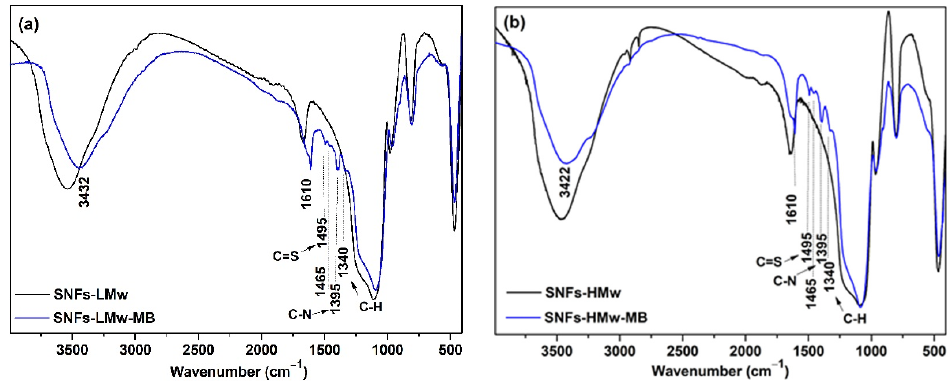
Figure 8. FTIR spectra before and after MB adsorption for ( a ) SNFs-LMw and ( b ) SNFs-HMw.